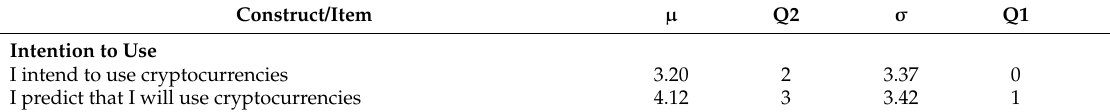
Table A1. Descriptive statistics of our